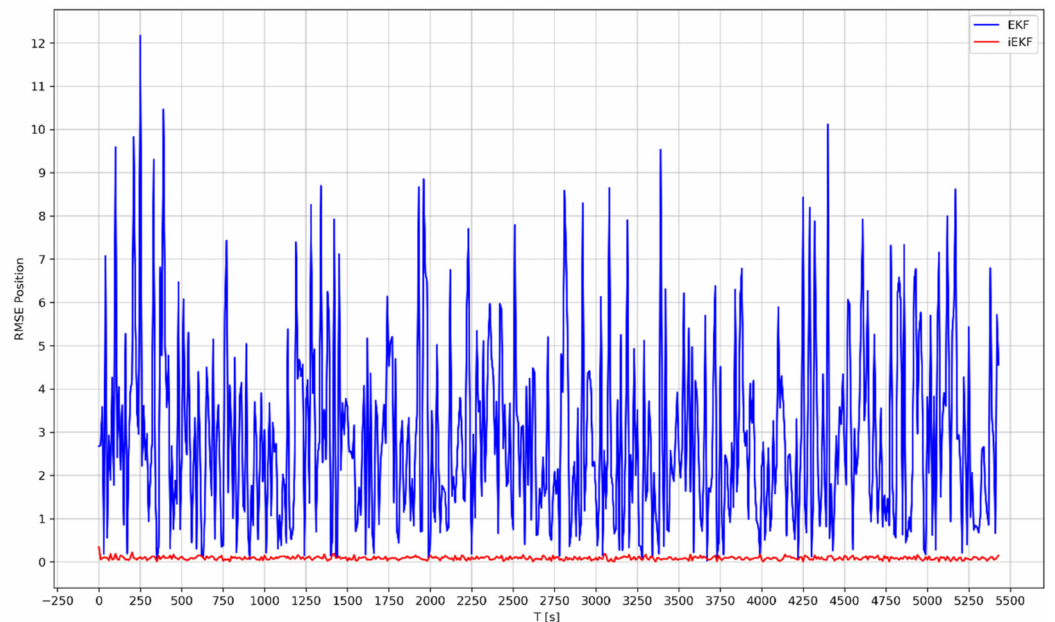
Figure 7. Case 1: comparison of the EKF RMSE and iEKF RMSE for the